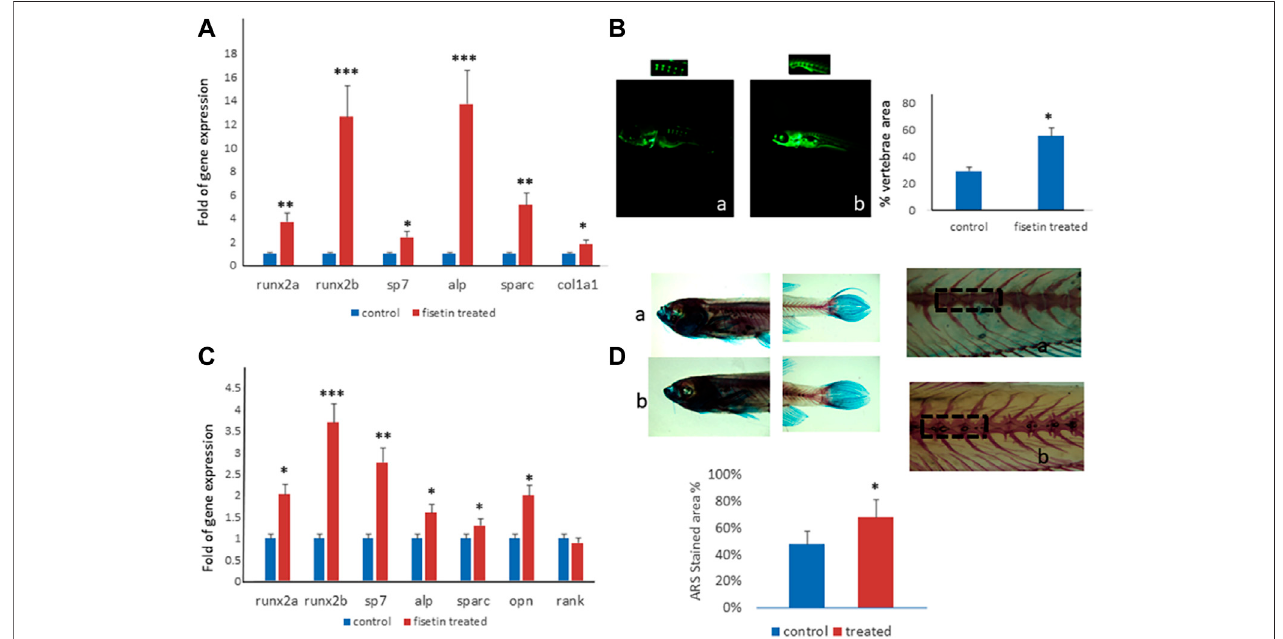
FIGURE5| Fisetineffectsoninvivomodel.Fisetinsupplementation increasedosteogenicgenesexpressioninzebra fi shlarvaeafter7(9dpf)daysoftreatment (A) . The fl uorescence density produced bycalcein staining showed an increased vertebrae area in larvae after 7 days of fi setin (B) . Osteogenic geneswere upregulated also inadultzebra fi shsupplementedwith fi setinfor14days (C). Fisetinsupplementationfor14daysincreasedbonemineralization,evaluatedbyAlizarinredstaining(ARS)in adult zebra fi sh (D) . * p < 0.05; ** p < 0.01; *** p < 0.005.